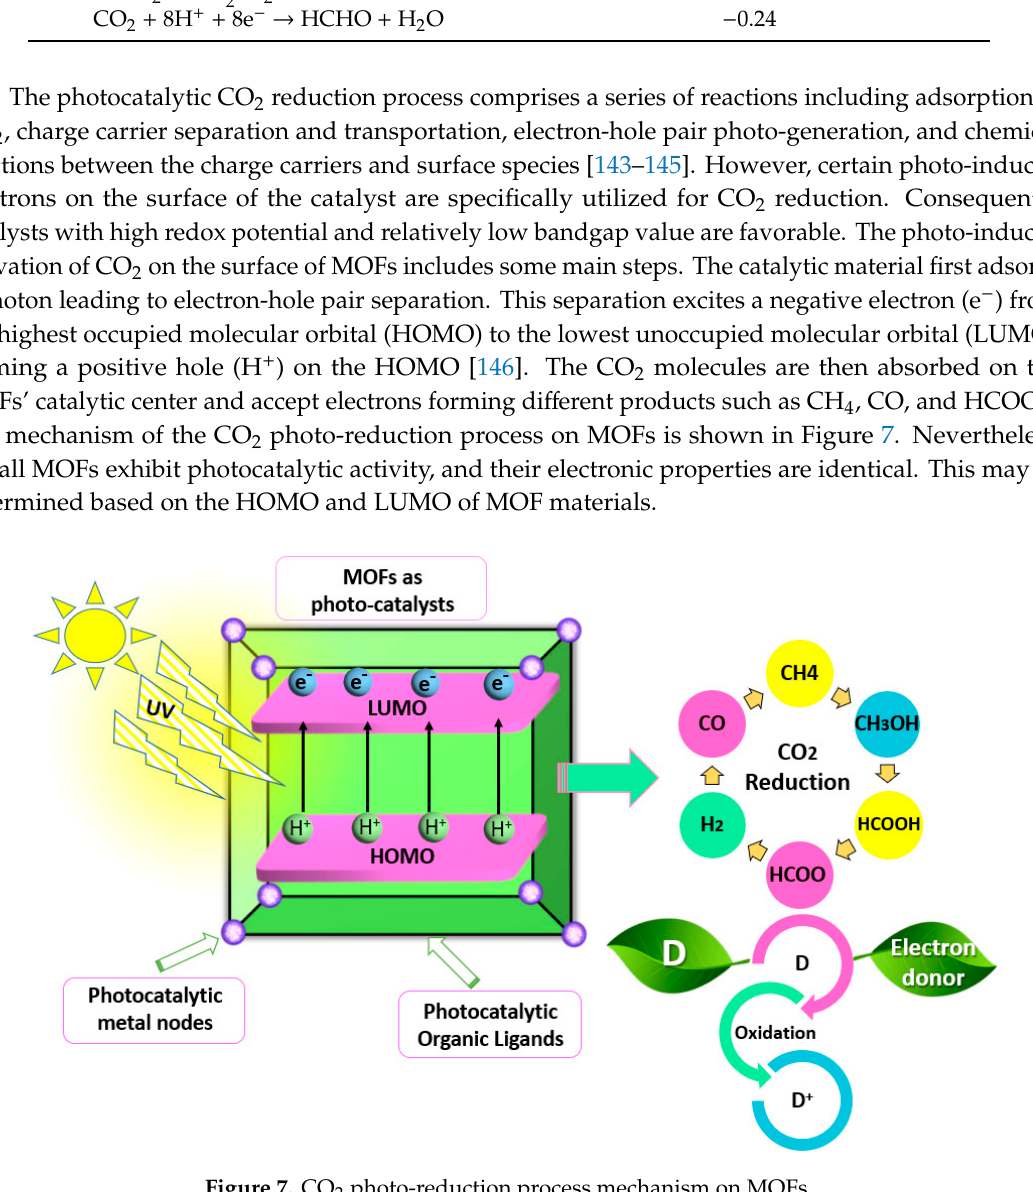
Figure 7. CO 2 photo-reduction process mechanism on MOFs.